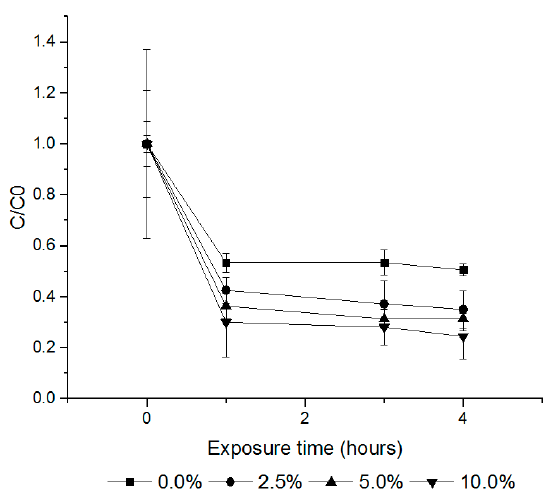
Figure 5. The amount of EF loss according to the different loading ratios of cured tobacco leaves (control, 2.5%, 5.0% and 10.0% ( w / v )). Each value represents the mean ± SE ( n = 3). C / C0 is the ratio of the concentration of the fumigant in the headspace. Insects 2020 , 10 , x